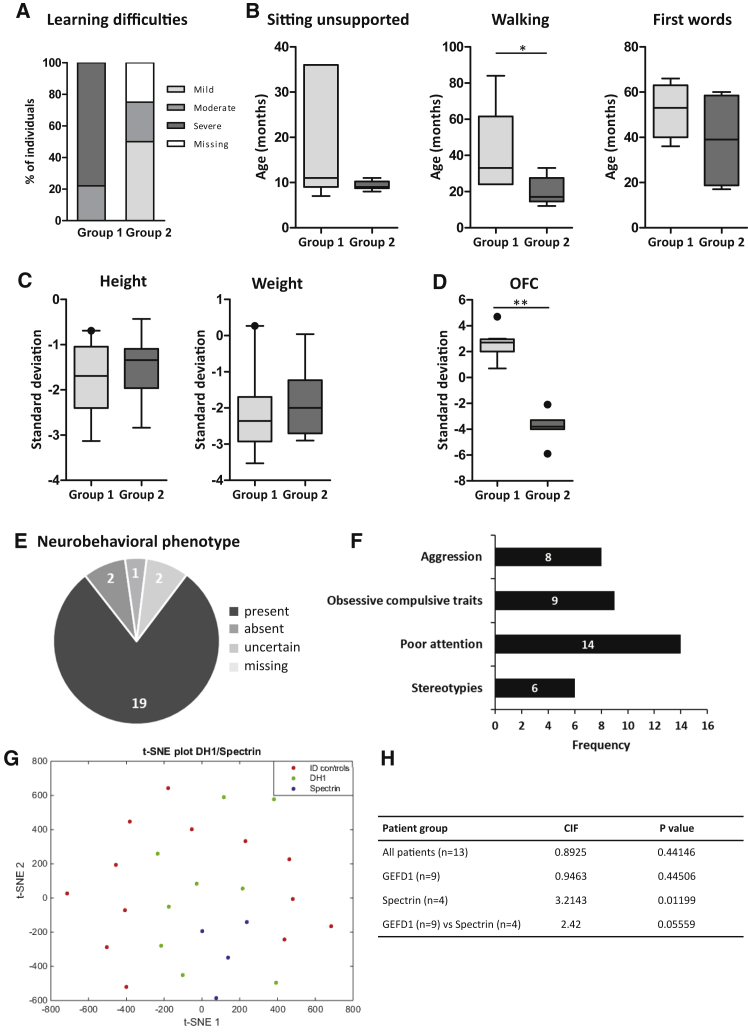
Individuals Harboring Variants in Either GEFD1 or Spectrin Domains Show Distinct Neurodevelopmental Phenotypes(A) Percentage of affected individuals with different levels of learning difficulties in either spectrin domain (group 1) or GEFD1 (group 2) mutation cases. 75% of group 2 individuals have mild-moderate learning difficulties. 78% of group 1 individuals have severe learning difficulties.(B) Early developmental milestones (sitting unsupported, walking, and first words) are delayed in both group 1 and group 2 individuals, but group 1 individuals are affected more severely. For statistical analysis, refer to Table S3. Walking: ∗p = 0.035.(C) Height and weight standard deviations from mean in either group 1 or group 2 individuals. The median height for group 1 individuals with spectrin mutations was −1.69 SD, and for group 2 individuals with GEFD1 mutations it was −1.34 SD. 33% of the individuals in group 1 and 14% of individuals in group 2 had a height SD of greater than −2 SD, which is often considered as short stature. Weight SD was also reduced in both groups.(D) Microcephaly was seen in 100% of group 2 individuals, who had a mean OFC of −3.82 SD (median OFC of −3.8 SD). Individuals within group 1 present with macrocephaly. 78% had an OFC greater than 2 SD from the mean; mean OFC was +2.6 SD, median OFC was + 2.7 SD, and OFC range was between +0.7 SD and +4.7 SD. ∗∗p < 0.001 (Table S3)(E) A neurobehavioral phenotype was observed in 19 out of the 24 (79%) individuals described in this study.(F) Recurrent behavioral features include stereotypies (6/24 patients), poor attention (14/24 individuals), obsessive-compulsive traits (9/24 individuals), and aggression (8/24 individuals). In total, 2/24 were identified as social or friendly.(G and H) Quantitative facial phenotyping. t-distributed stochastic neighbor embedding (t-SNE) plot of the vectors of individuals with alterations in GEFD1 and the seventh spectrin domain and the matched controls with intellectual disability. The statistically significant clustering of individuals with mutations in the spectrin domain indicates a recognizable facial phenotype.